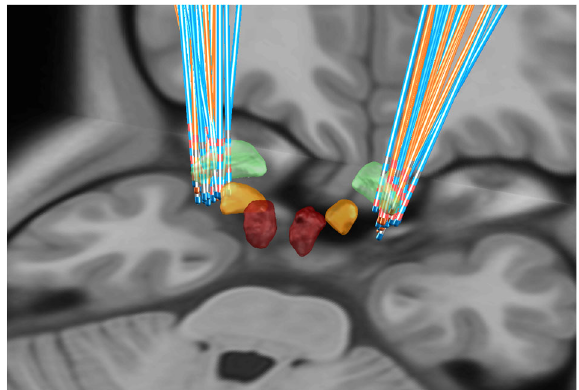
Fig. 4 Reconstruction of the DBS electrodes. The electrodes of 10 patients with camptocormia (marked in orange) and 18 patients without camptorcormia (maked in blue) were shown on the T1- weighted Montreal Neurological Institute (MNI) template. Active contacts were marked in red. Masses with yellow described the location of the STN, red for the red nucleus, and green for the